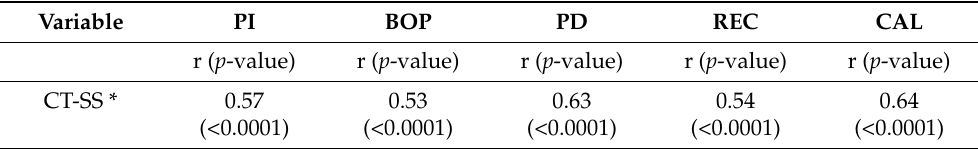
Table 4. Correlation of HRCT scores with periodontal